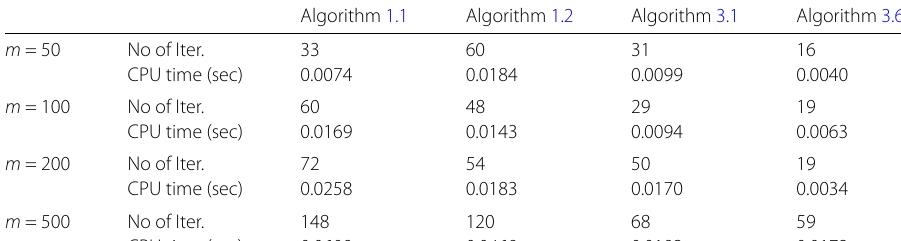
Table 1 Computation result for Example 4.1